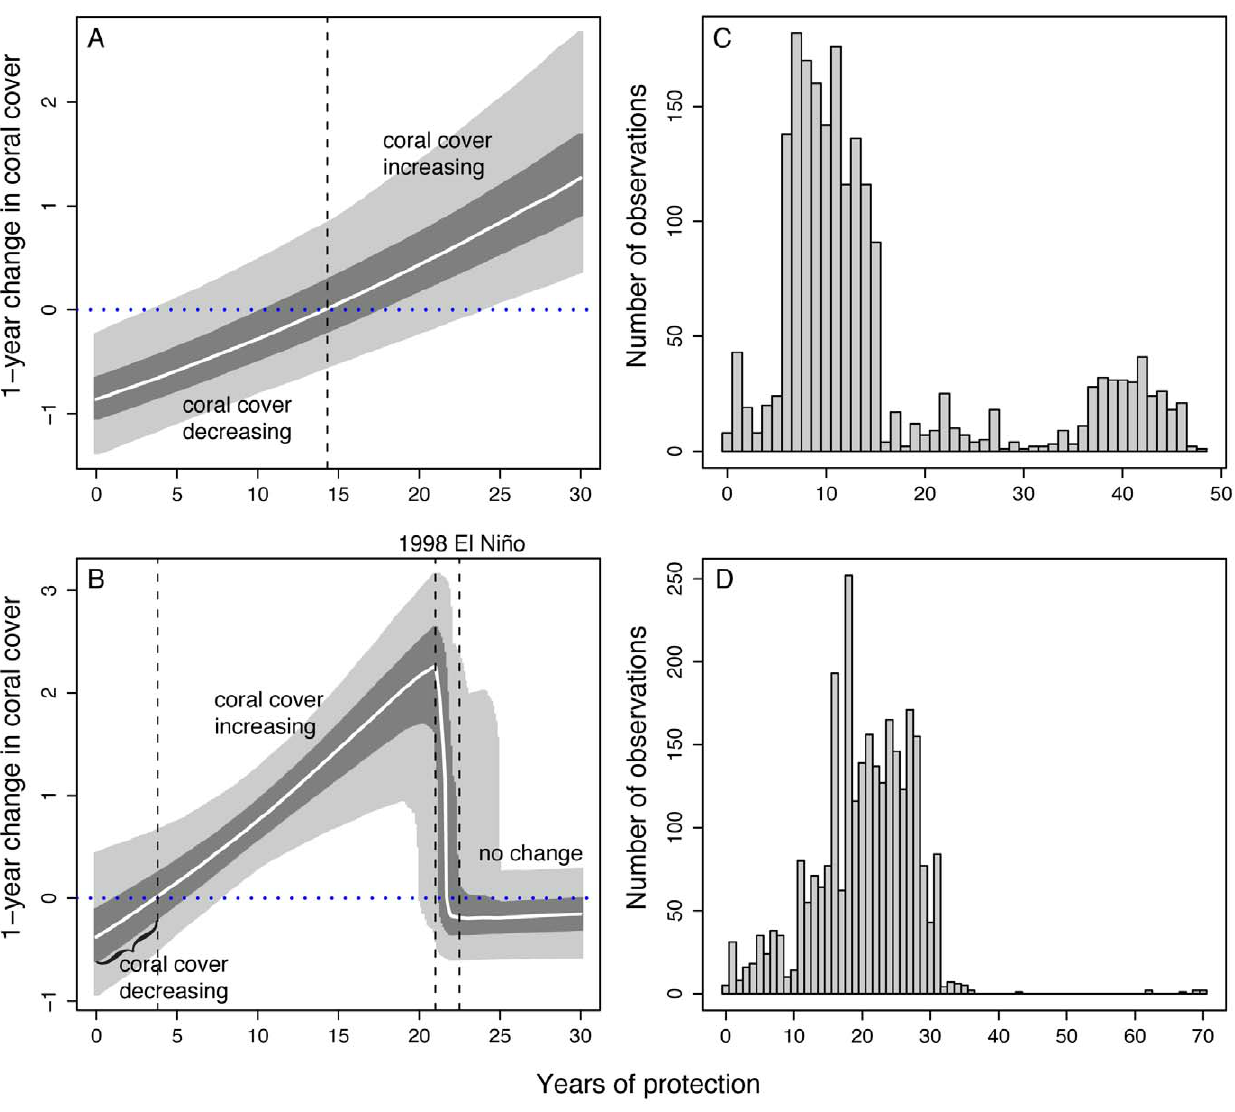
Figure 4. The effect of the number of years of protection on the 1-year change in coral cover and number of observation. Coral cover change rates are shown in the ( A ) Caribbean and ( B ) Indo-Pacific with the 95% credibility intervals (light grey bands) and the 50% credibility intervals (dark grey bands) as well as the median (white line) of the posterior distributions of the year of protection models using all years of data and 2005 coral cover change rates. The number of years of protection by observations (surveys) in the ( C ) Caribbean and ( D ) Indo-Pacific show that most surveys have been performed when MPAs have been established for 15 years or less.